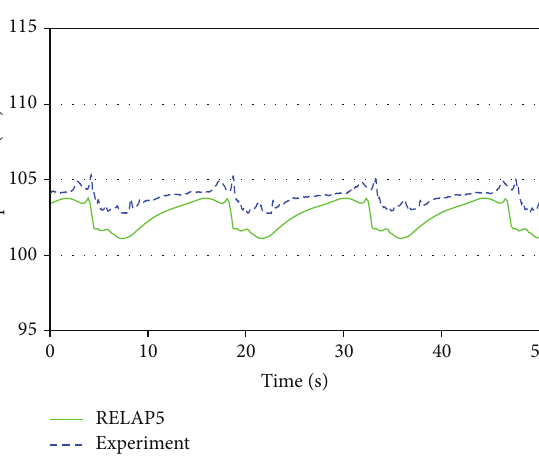
Figure 17: Outlet riser water temperatures, test I-2.